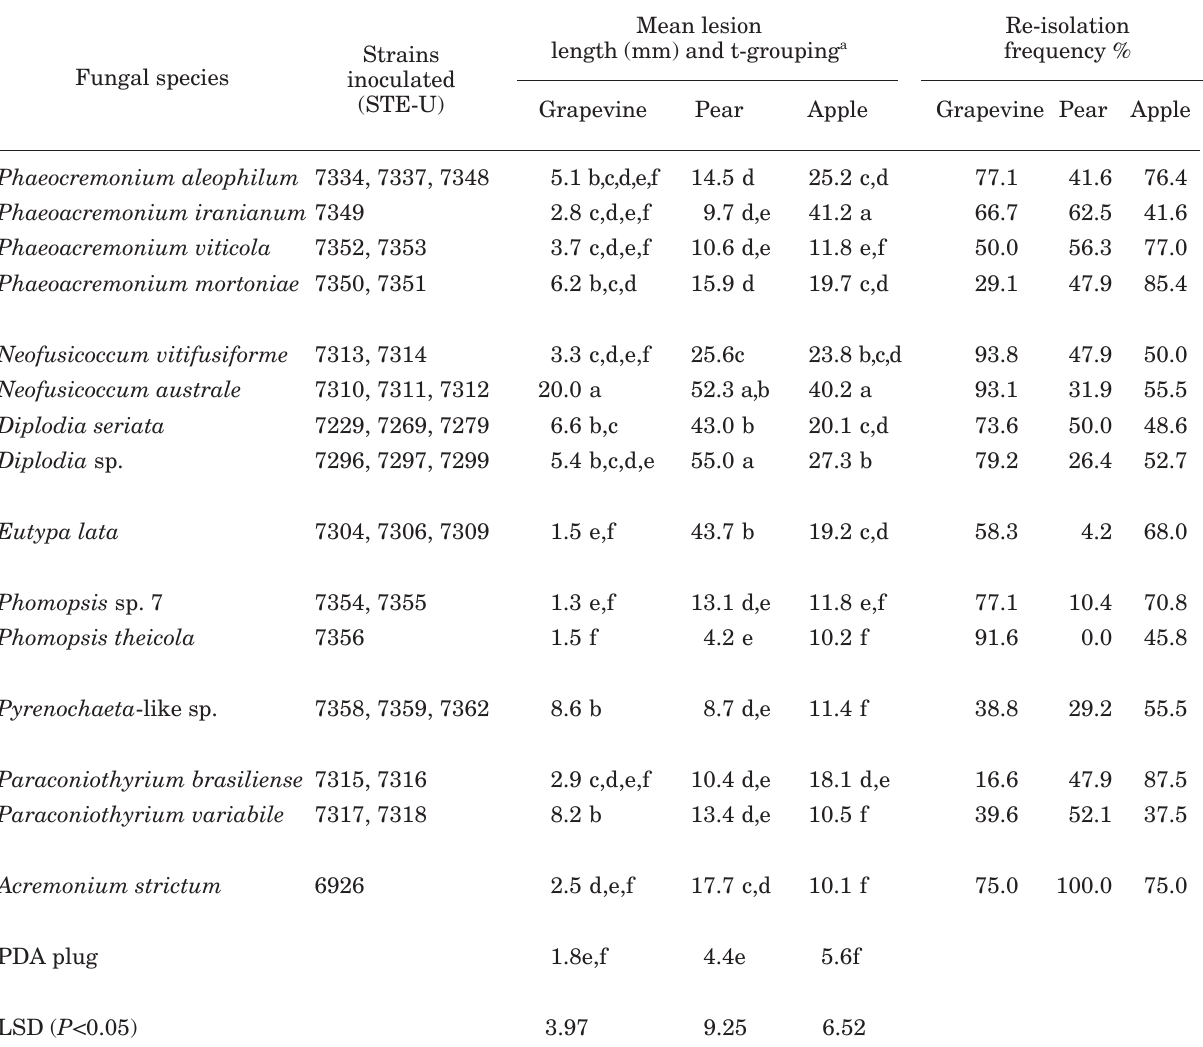
Table 1. Mean lesion length and re-isolation frequencies of fungal species inoculated onto detached grapevine, pear and apple shoots in a pathogenicity trial.